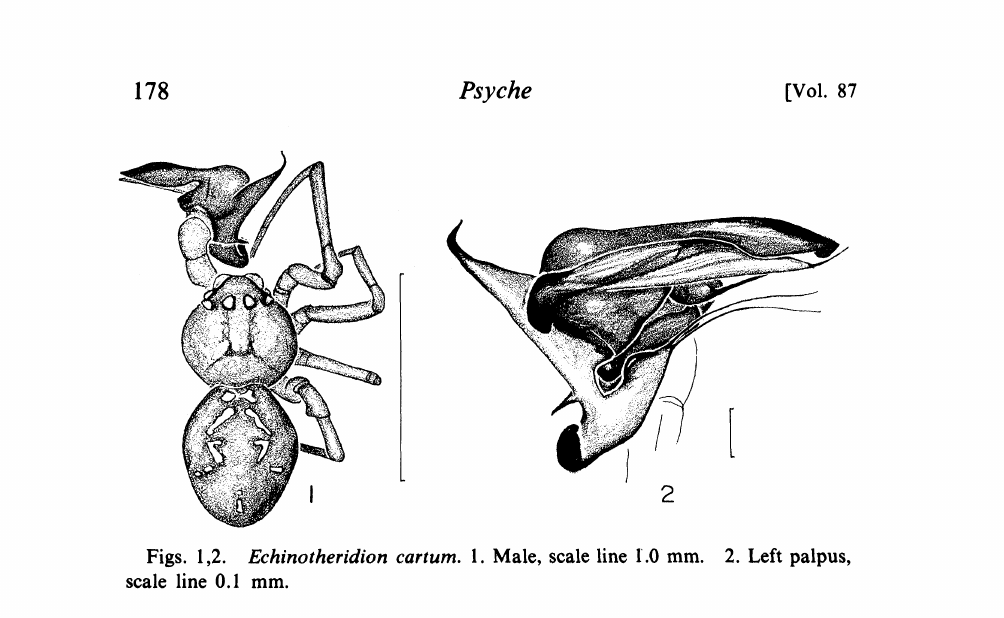
Figs. 1,2. Echinotheridion cartum. 1. Male, scale line 1.0 mm. 2. Left palpus, scale line 0.1